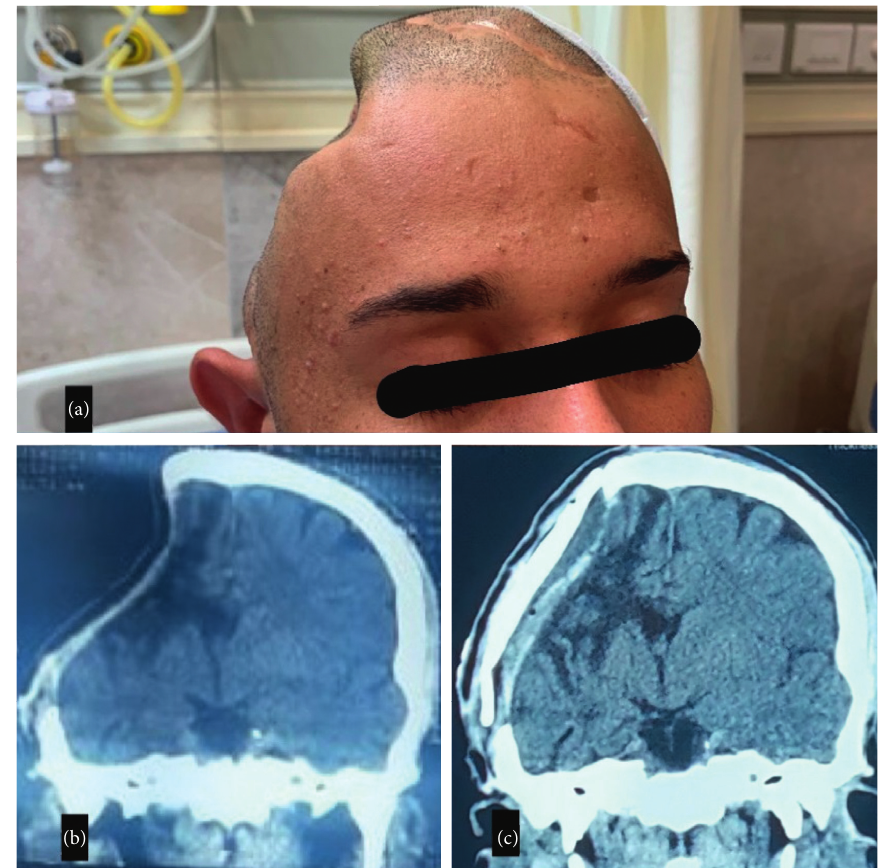
Figure 2: (a) Clinical photograph showing sunken skin flap 3 months after craniectomy. (b) Computed tomography (CT) plain brain, coronal view showing right-sided craniectomy with severely sunken hemisphere on the same side. (c) Computed tomography (CT) plain brain, coronal view on postoperative day 1, showing cranioplasty using flattened bone. Also, partial resolution of pressure effects can be